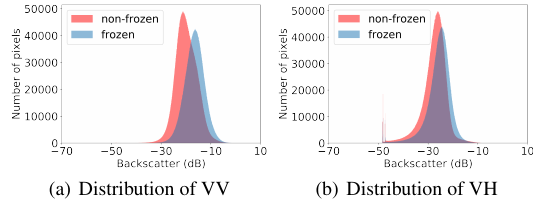
Figure 3: Distribution of frozen and non-frozen pixels for VV and VH polarisations (combined data from 3 lakes, 2 winters). Best if viewed on